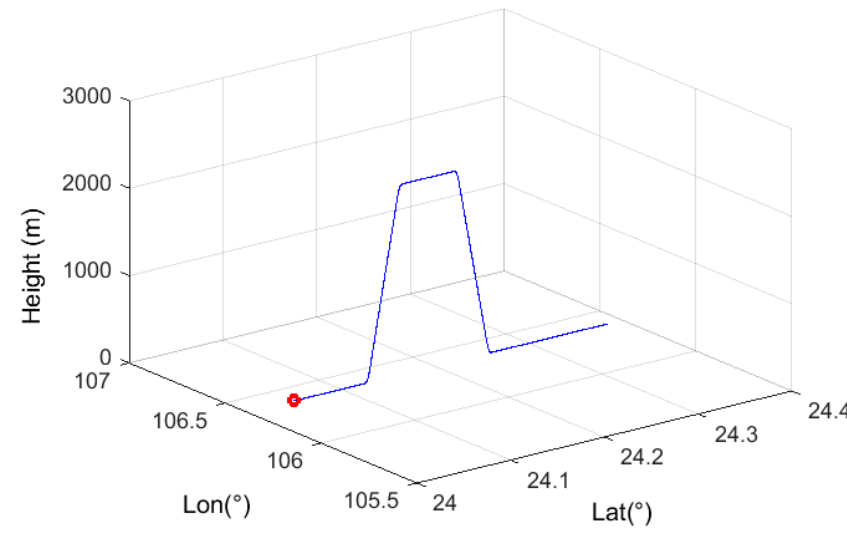
Figure 3. Simulated flight trajectory.